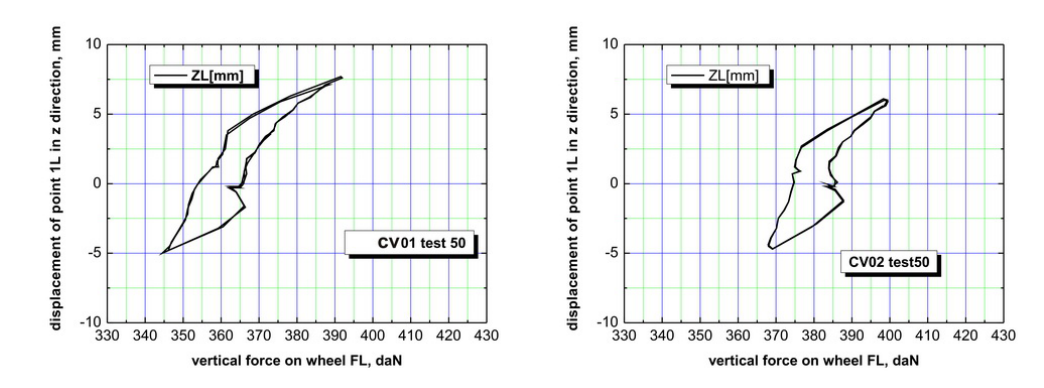
Fig. 5.3. Displacement alterations depending on vertical force during test No. 50.